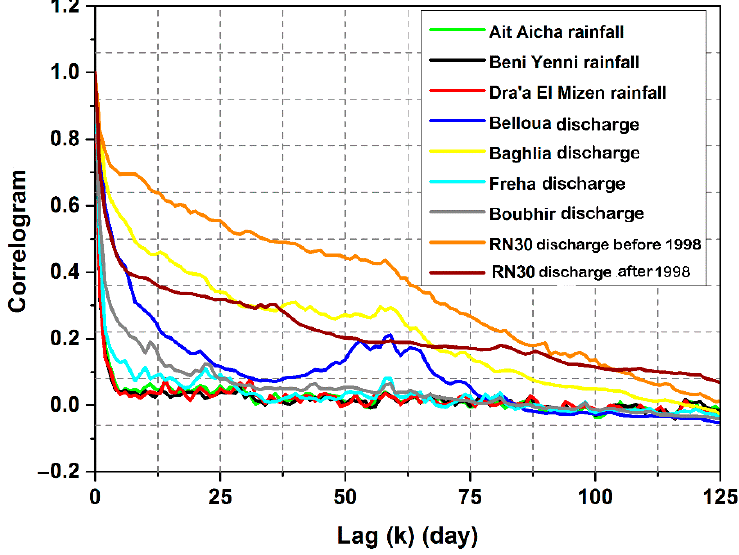
Figure 4. Time series of some ( a ) rainfall stations and ( b ) results of sequential Man Kendall test.